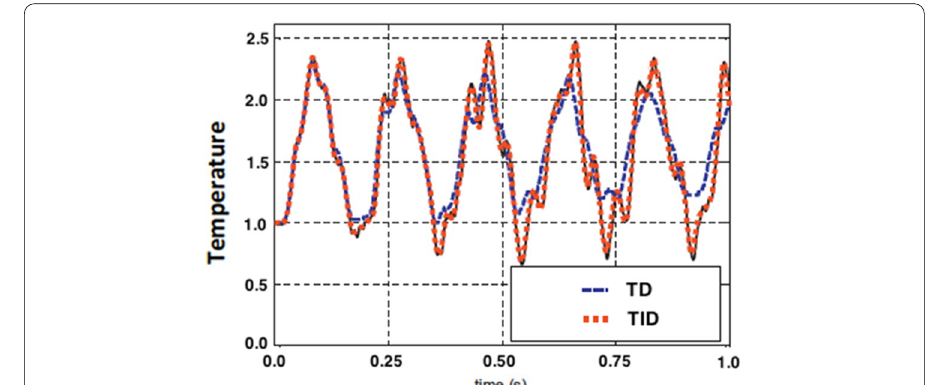
Fig. 3 Variation of the nonlinear temperature with time τ